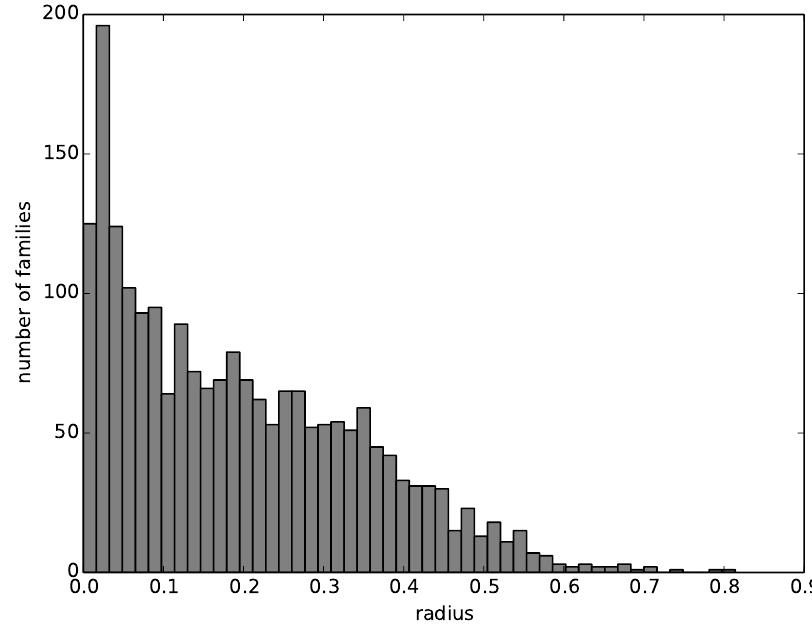
Figure 4. A histogram of the radii of the multi-member families.